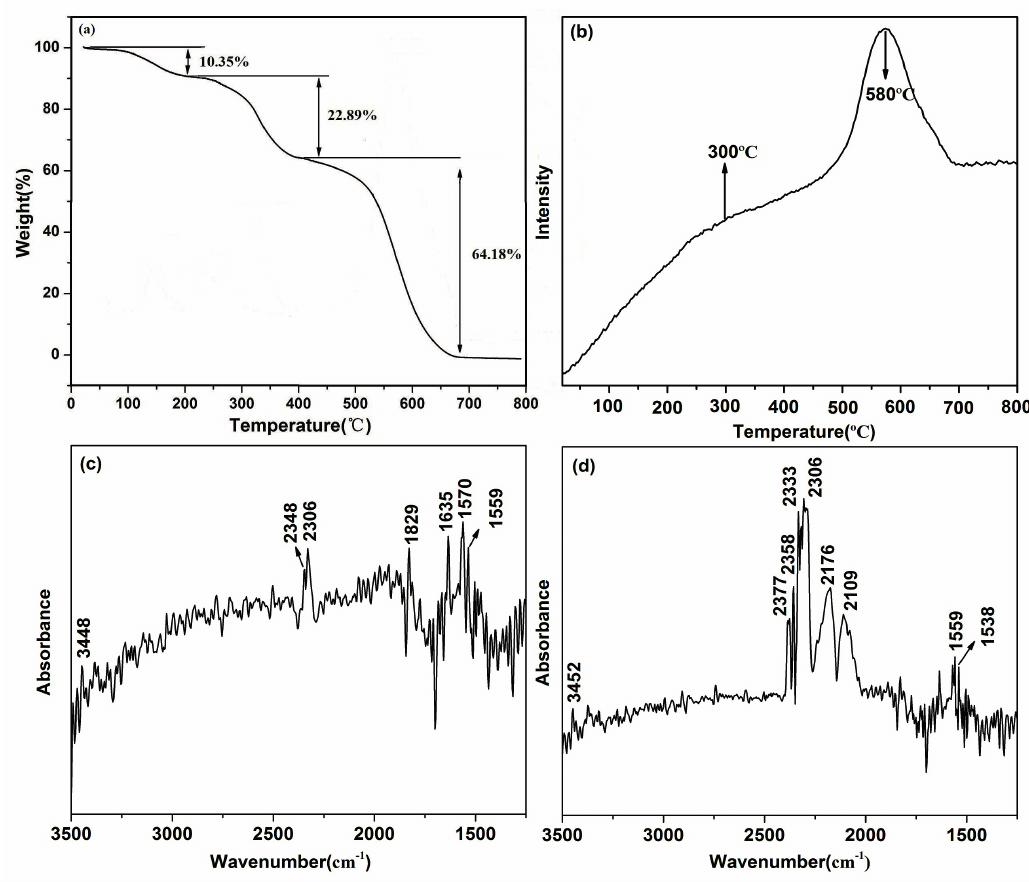
Figure 6. ( a ) TG curve of C 60 -GAP under air atmosphere; ( b ) IR absorption intensity of the gas released from C 60 -GAP by time diversification; FTIR spectra of the gaseous product released by C 60 -GAP at decomposition temperatures of ( c ) 300 °C, and ( d ) 580 °C.